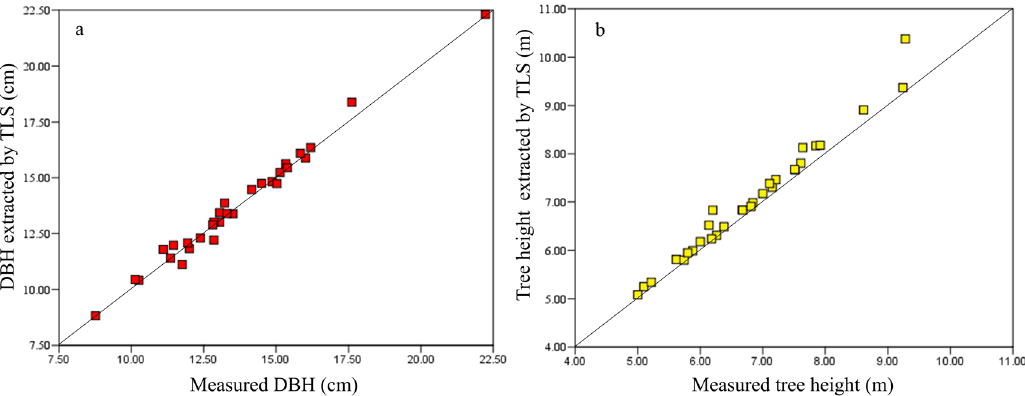
Figure 6. Comparison of ( a ) DBH and ( b ) tree height extracted by TLS with measured values.